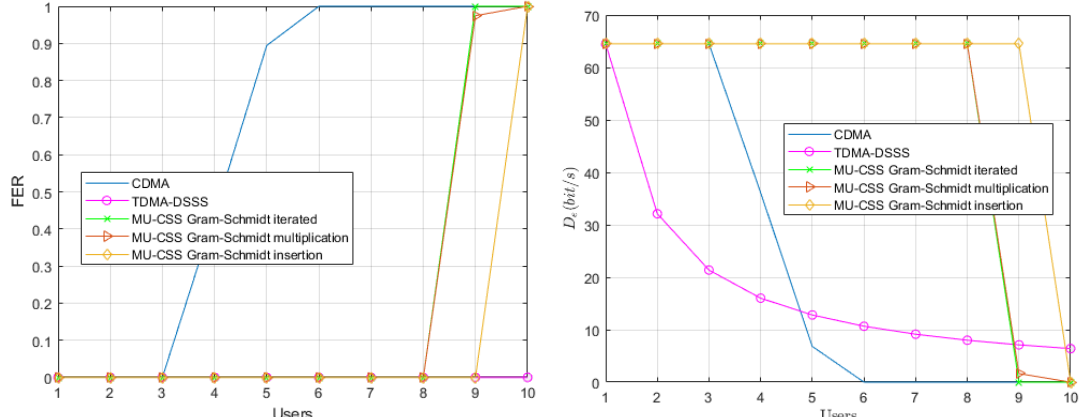
Figure 6. Average Frame Error Rate (FER) performance ( left ) and effective data rate ( right ) versus the number of users over the static simulated UWA channel